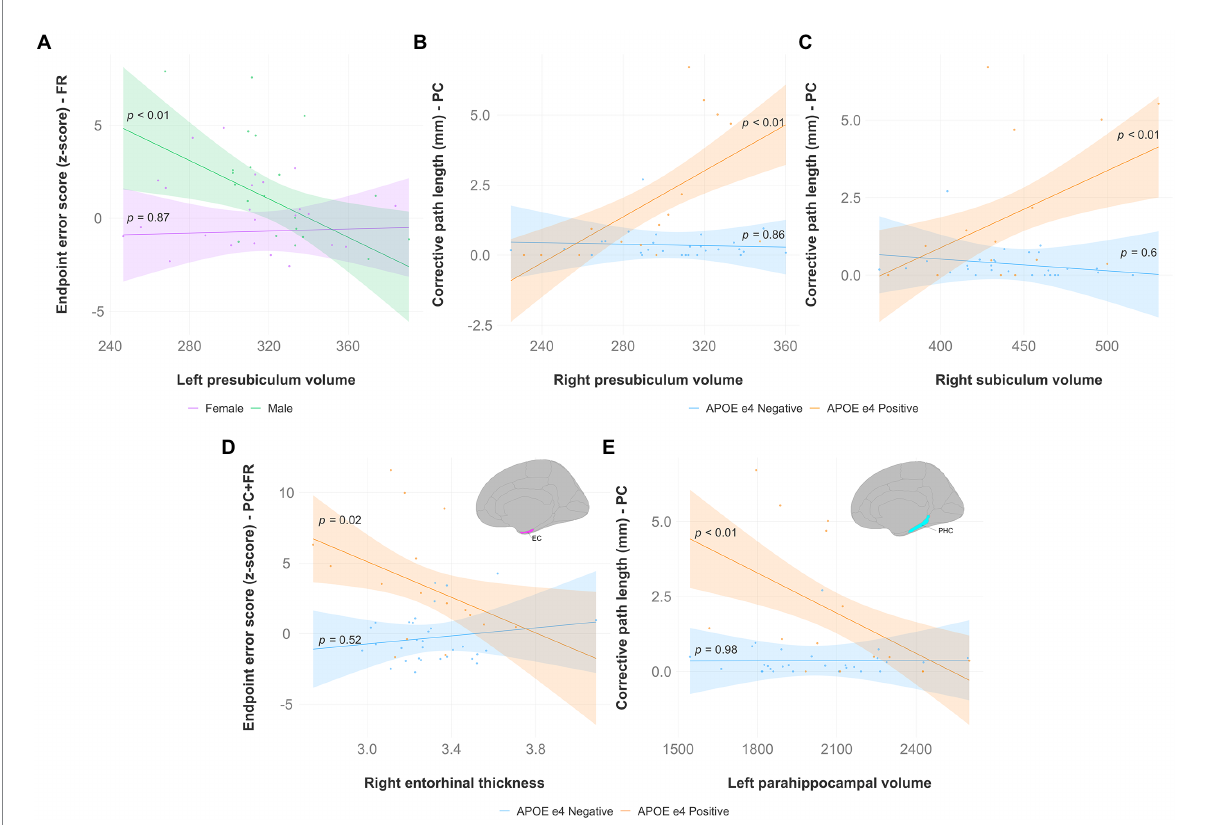
FIGURE 5 Significant results from hippocampal subfield, entorhinal, and parahippocampal multiple regression and simple slopes analyses. Top panel (A,B,C) : Hippocampal subfield volumes predict non-standard visuomotor task performance in the feedback reversal and the plane-change conditions. (A) Higher endpoint error scores, reflecting worse visuomotor performance, were associated with smaller left presubiculum volumes (simple slope = − 0.06, S.E. = 0.02, p < 0.01) only in males. Higher corrective path lengths, reflecting worse visuomotor performance, were associated with (B) greater right presubiculum volume (simple slope = 0.04, S.E. = 0.01, p < 0.01), and (C) greater right subiculum volume (simple slope = 0.02, S.E. = 0.01, p < 0.01) only in APOE e4 carriers. Bottom panel (D,E) : Entorhinal thickness and parahippocampal volume predict non-standard visuomotor task performance. (D) Higher endpoint error scores, reflecting worse visuomotor performance, were associated with lower right entorhinal cortical thickness in the plane-change feedback reversal condition (simple slope = − 6.32, S.E. = 2.70, p = 0.02) only in APOE e4 carriers. (E) Higher corrective path lengths, reflecting worse visuomotor performance, were associated with lower left parahippocampal volume in the plane-change condition (simple slope = − 0.004, S.E. = 0.001, p < 0.01) only in APOE e4 carriers. Brain figures made with “ggseg” R package (Mowinckel and Vidal-Piñeiro, 2020). EC, entorhinal cortex; PHC, parahippocampal cortex; FR, feedback reversal; PC, plane-change; PC + FR, plane-change feedback reversal; APOE, apolipoprotein